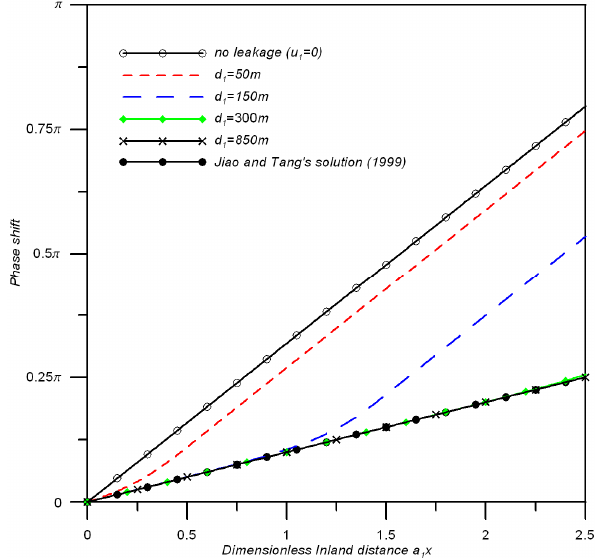
Figure 4. The curves of normalized amplitude of the head fluctuation versus dimensionless inland distance for u 1 = 0, u 2 = 5, a 1 = a 2 = 1 × 10 − 2 m − 1 , and various values of d 1 .